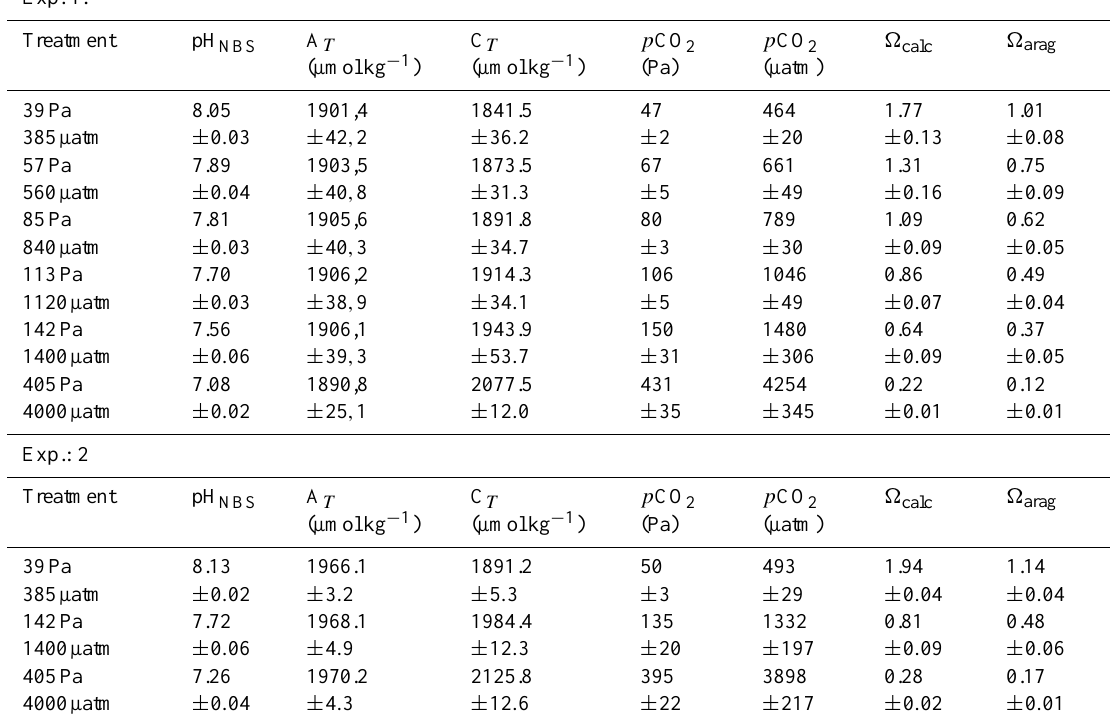
Table 2. Seawater carbonate system speciation during experimental trials (mean ± SD, 14 and 3 determinations for pH, S , T and A T , C T ) . Salinity ( S ) was 11.8 ± 0.4 and temperature ( T ) 12.5 ± 0.5 ◦ C in Exp. 1 (duration 2 weeks), S = 15 . 0 ± 0.6 and T = 13 . 8 ± 0.6 ◦ C in Exp. 2 (duration: 8